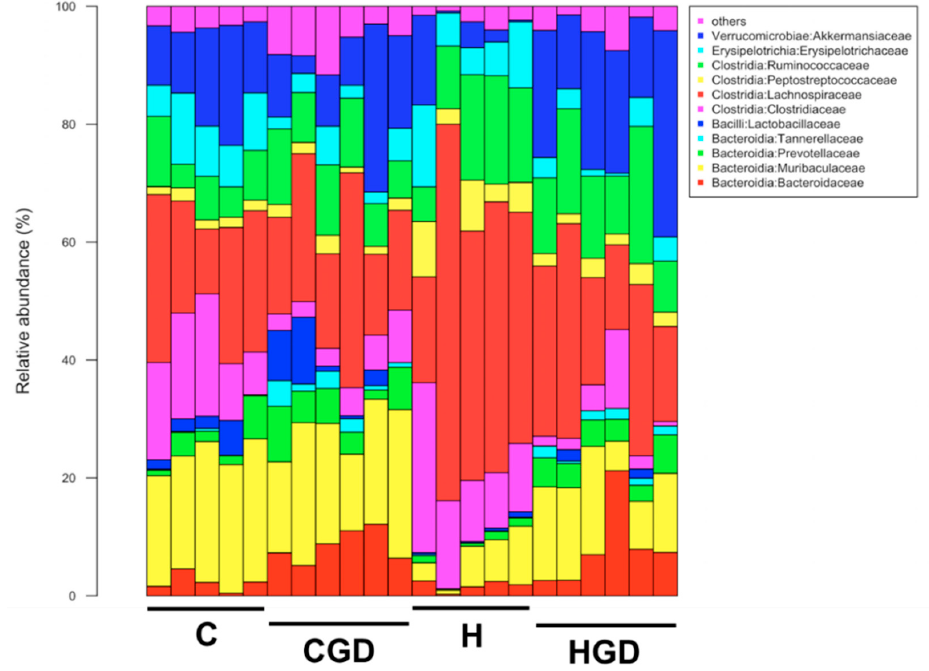
Figure 11. Taxonomic profiles of bacterial communities shown at the family level. C, corn starch diet-fed rats; CGD, corn starch diet-fed rats treated with Garcinia dulcis rind powder; H, high-carbohydrate, high-fat diet-fed rats; HGD, high-carbohydrate, high-fat diet-fed rats treated with Garcinia dulcis rind powder.